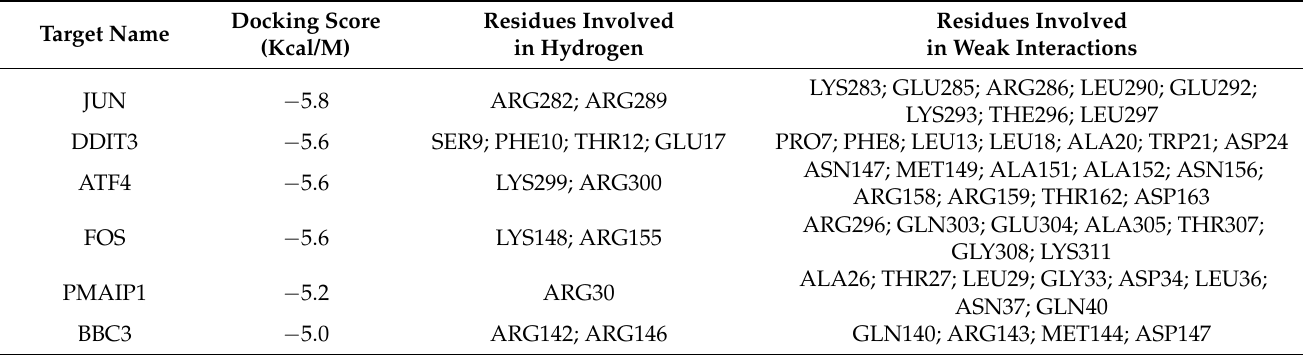
Table 2. Molecular docking